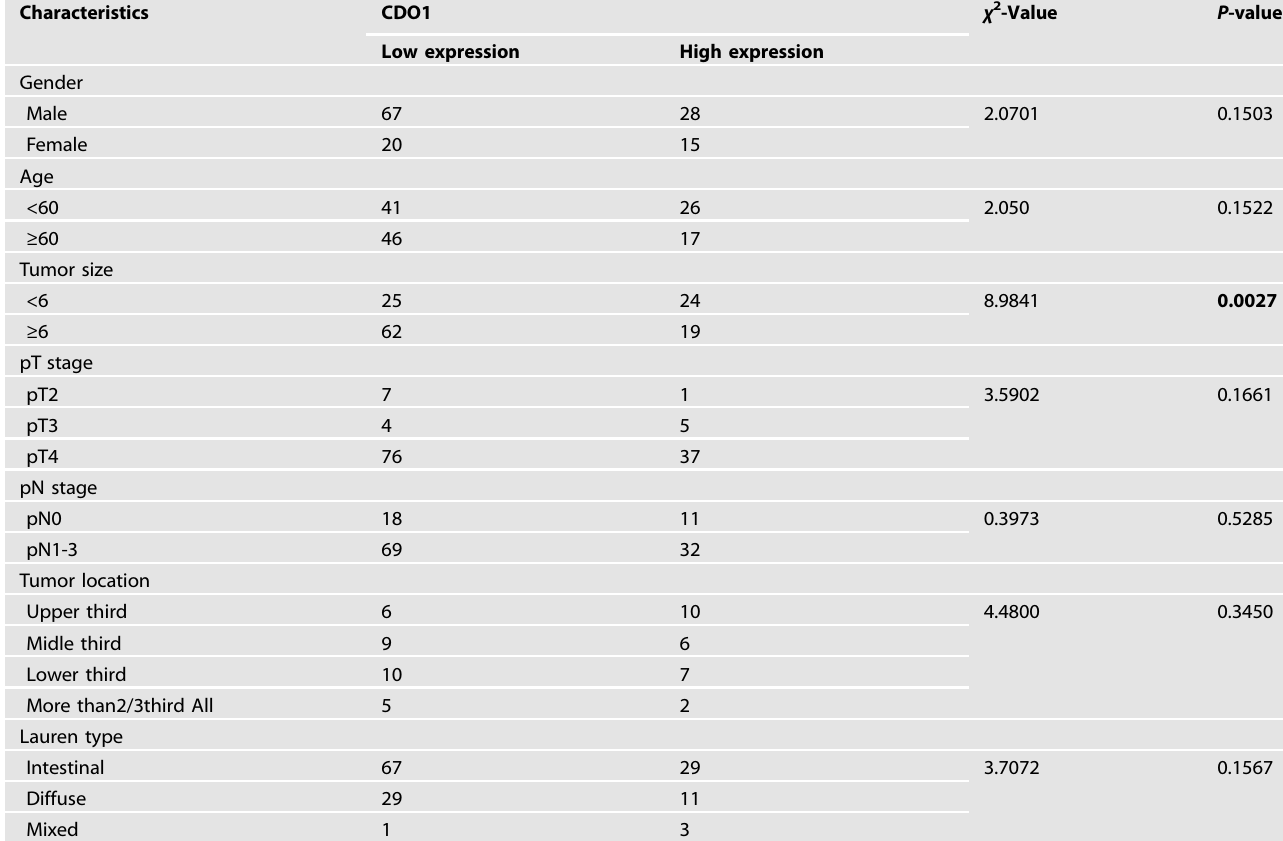
Table 2. The clinical relevance of CDO1 expression in patients with GC.